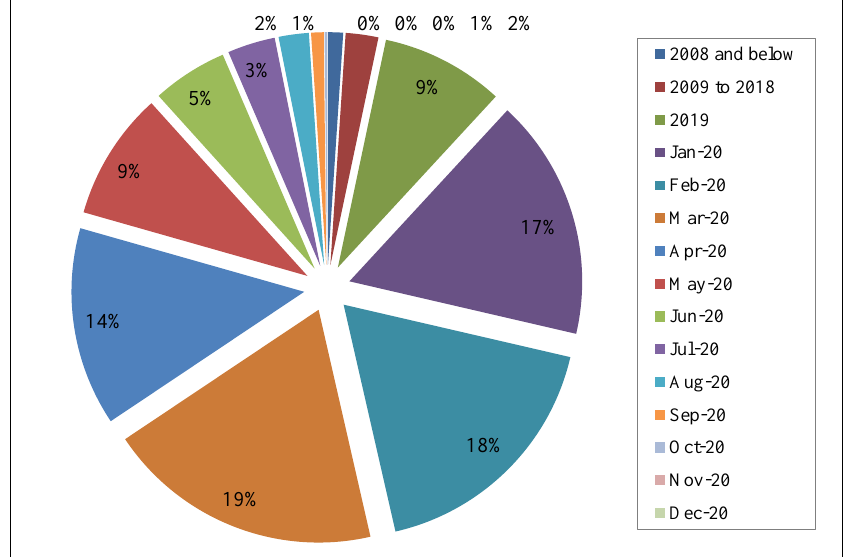
Figure 7. Percentage of Crisis Months/Periods used in